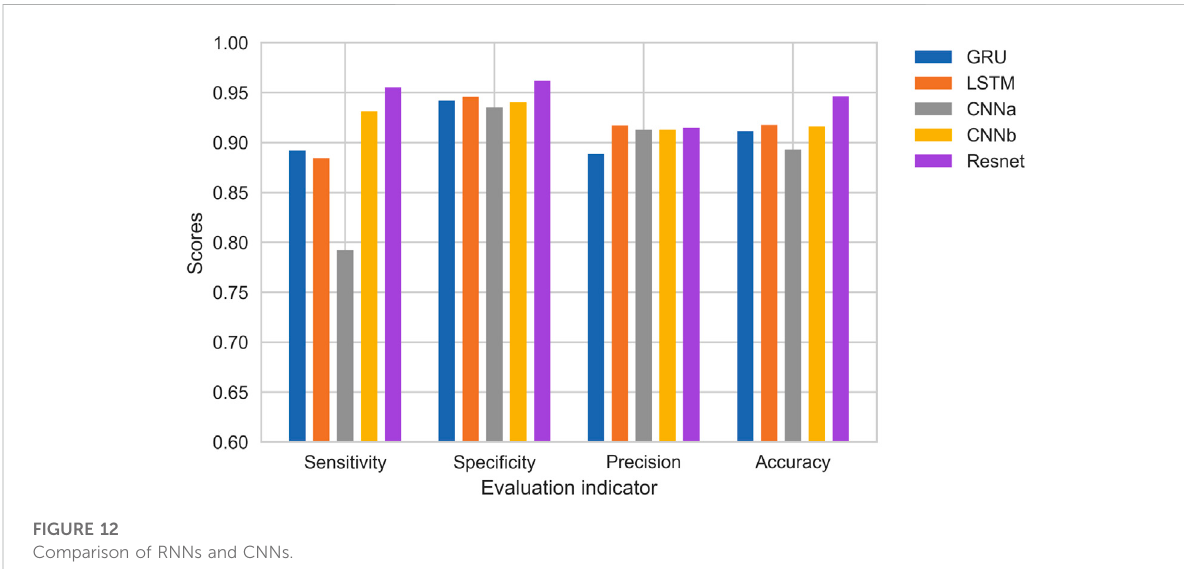
FIGURE 12 Comparison of RNNs and CNNs.